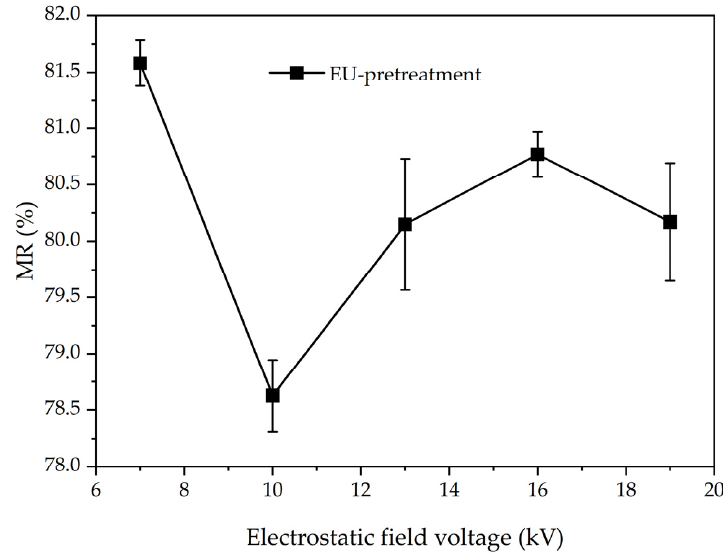
Figure 5. Effect of electrostatic field voltage on moisture of Ginkgo